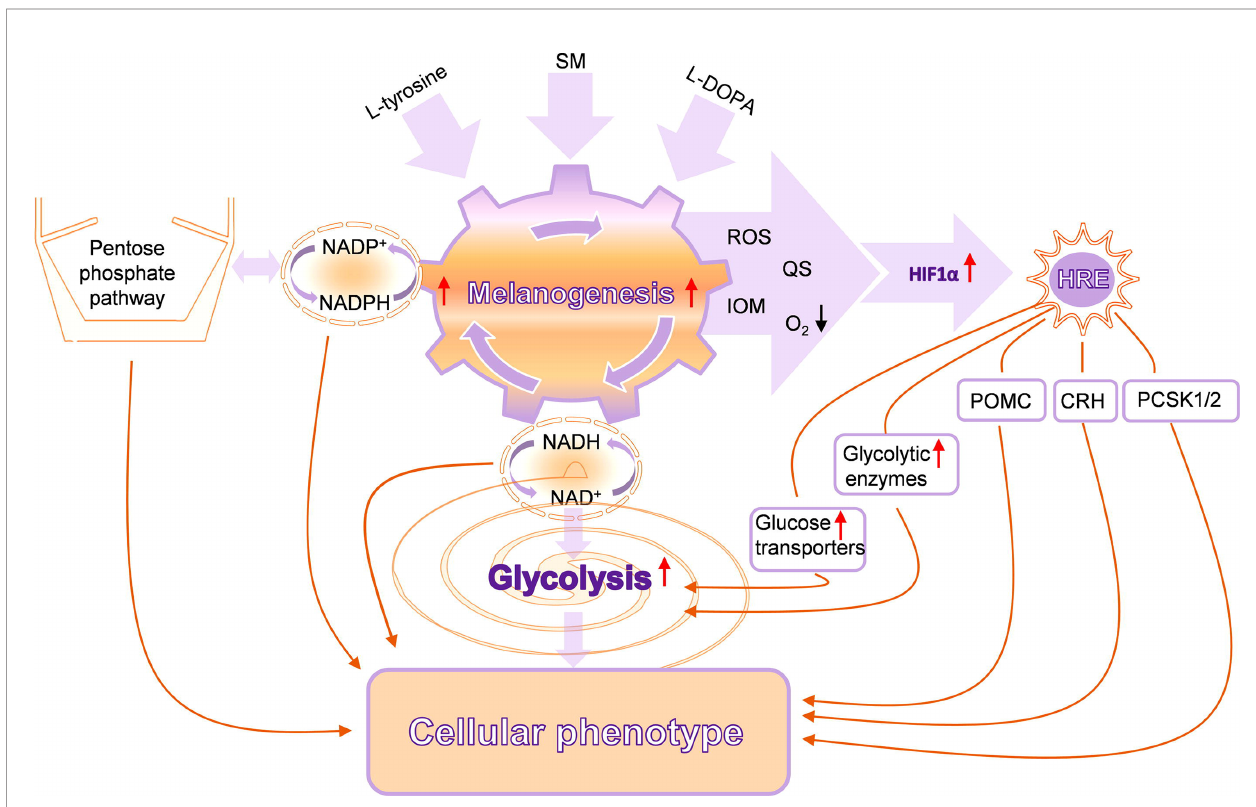
FIGURE 3 | Complex interactions between melanogenesis, glucose metabolism, and HIF-1-dependent pathways. SM, stimulators of melanogenesis; ROS, reactive oxygen species; QS, quinones and semiquinones; IOM, intermediates of melanogenesis; POMC, proopiomelanocortin; CRH, corticotropin-releasing hormone; PCSK1/2, proprotein convertase subtilisin/kexin types 1 and 2. Reproduced from (207) with a permission from the